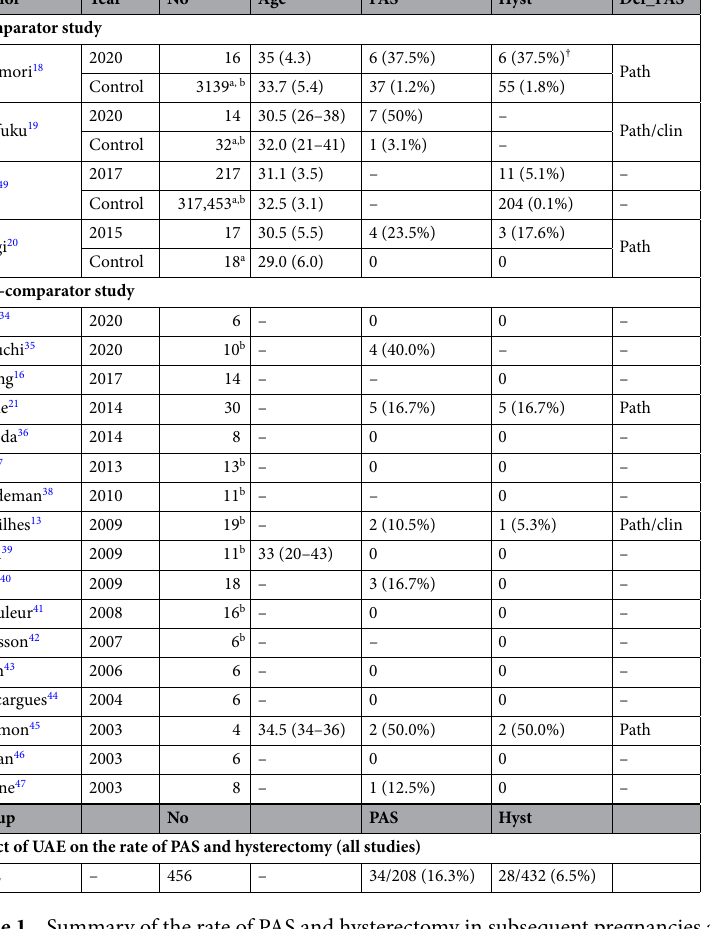
Table 1. Summary of the rate of PAS and hysterectomy in subsequent pregnancies after UAE. The median (range) or mean (standard deviation) or number (percentage per column) is shown. a Women without prior UAE. b Some patients had multiple deliveries. Some values listed above might be slightly different from the original values, as estimated by the authors. UAE uterine artery embolization, No . number of prior uterine embolization cases, PAS placenta accreta spectrum, Hyst hysterectomy, Def_PAS definition of placenta accreta spectrum, Path pathology, clin clinical